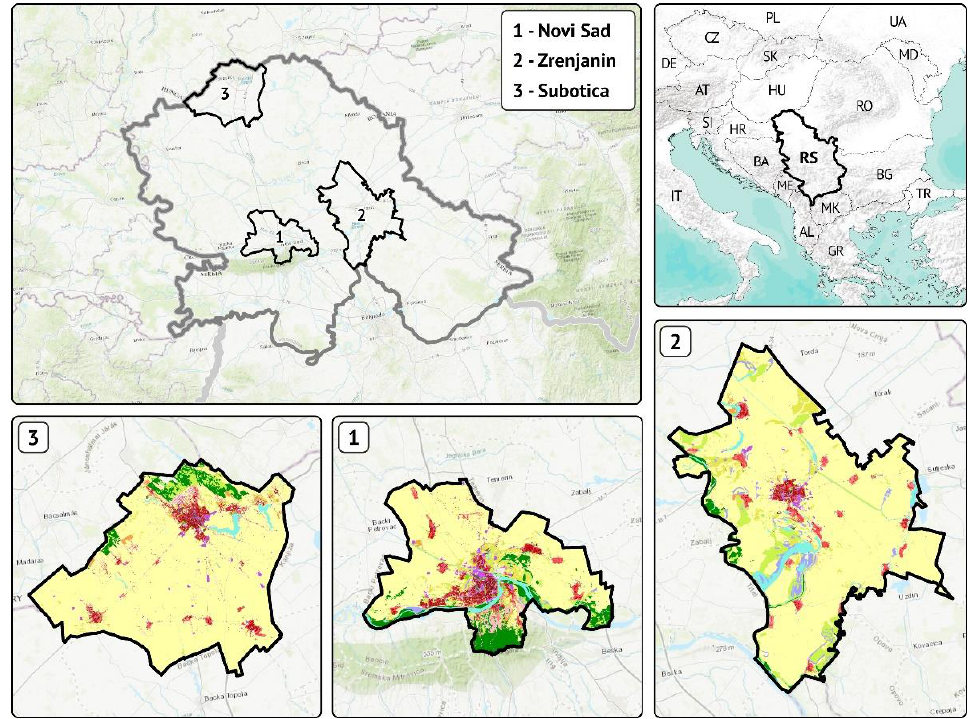
Figure 1. Study sites. ( 1 ) Municipality of Novi Sad; ( 2 ) Municipality of Zrenjanin; ( 3 ) Municipali-ty of Subotica. The legend for subfigures 1, 2, and 3 is presented in Figure 2a (LULC). Novi Sad is the regional and political-administrative center of Vojvodina. It is located in the central part, by the Danube River and occupies a total area of 69,884.33 ha. Novi Sad is the largest town in Serbia, after Belgrade (the capital of Serbia). According to the 2011 Census, its population is 341,625 inhabitants with a tendency of further growth [51]. A high degree of urbanization (over 70%) indicates the dominance of urban population with an increase of 4.6% in the next 25 years [52]. Significant protected areas in the terri- tory of Novi Sad are Fruška gora National Park which is recognized as a Primary Forest [53], as well as the Koviljsko-Petrovaradinski rit Special Nature Reserve (SNR) and Be- gečka jama Nature park [ 54]. Zrenjanin is located in the eastern part of Vojvodina, on the banks of the Begej and Tisza Rivers. In terms of the area occupied, Zrenjanin (total area is 132,019.64 ha) is the largest town in AP Vojvodina and the second largest in Serbia. According to the 2011 cen- sus, the municipality has 123,362 inhabitants, with a trend of continuous population [51]. The urbanization rate of the municipality is 60.41% with a tendency of increase in urban population [55]. The most important protected areas are in the category of wetlands: SNR Carska bara, Nature Reserves Ritovi Donjeg Potisja, Okanj Bara and Rusanda Nature Park [54]. Subotica is located in the north of Vojvodina, on the border with Hungary. The total area of the municipality is 100,584.5 ha. According to the 2011 census, the municipality of Subotica has 141,554 inhabitants, with a negative trend in population movements even with 72.2% degree of urbanization [51]. In the territory of Subotica, the protected natural areas are Subotica- Horgoš Sands Nature Park, SNR Ludaš Lake, SNR Selevenj heath and Palić Nature Park [ 56].